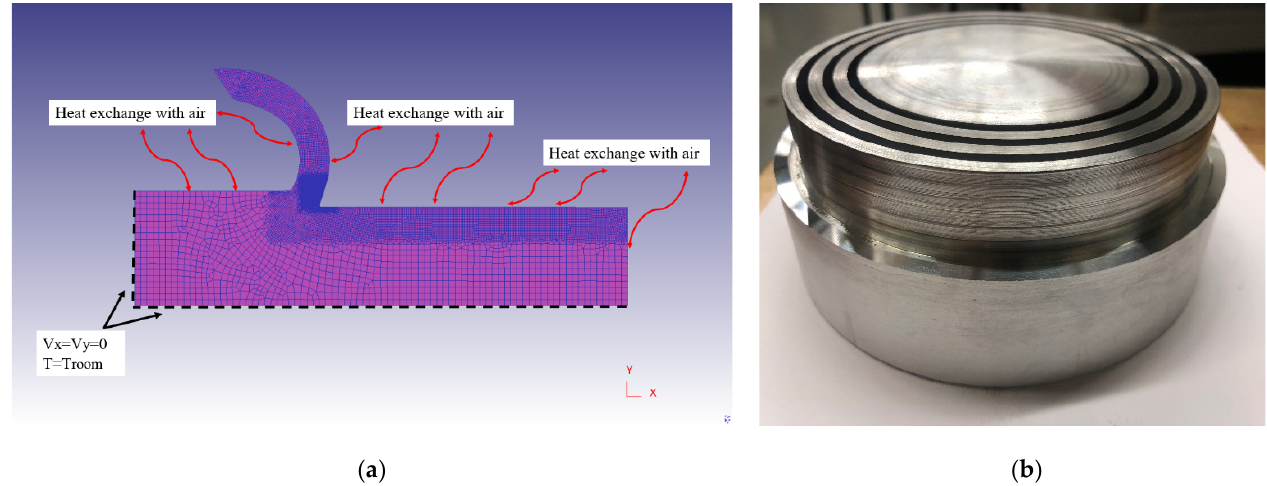
Figure 13. Thermal and mechanical boundary conditions in the stress relaxation process of ( a ) FE model and ( b ) Exp. test.